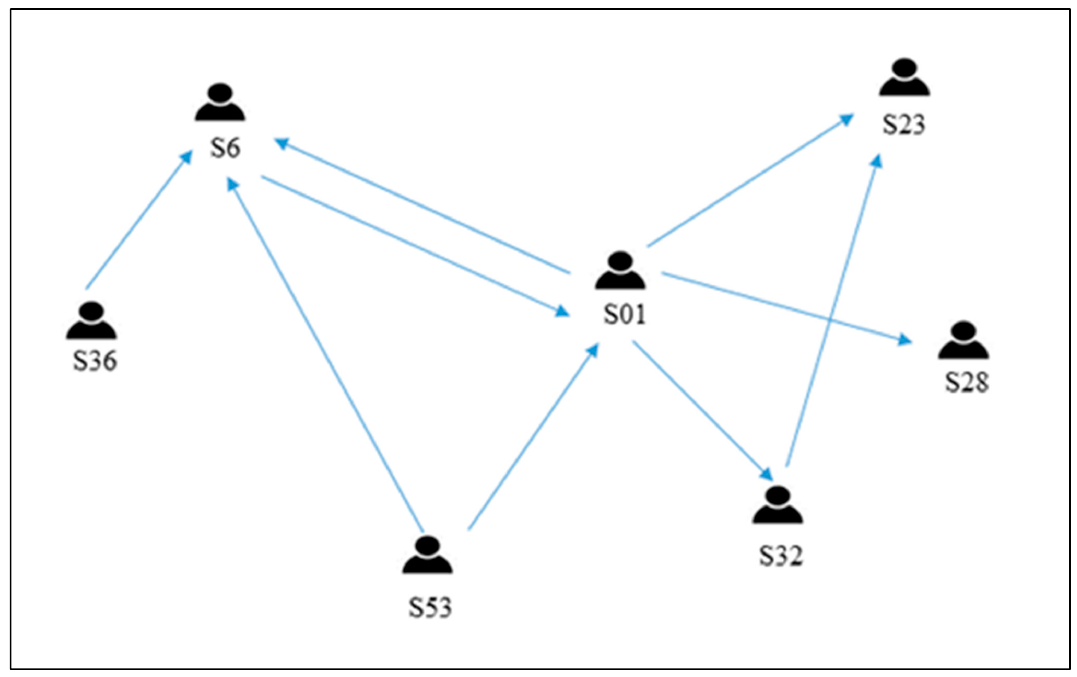
Figure 2. A portion of student physical interaction during the mathematics tutorial session.